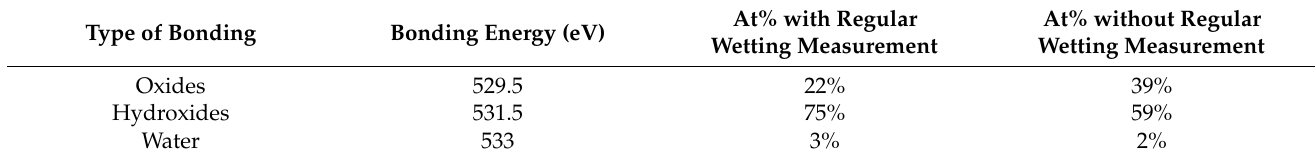
Table 3. Atomic percentages of the different oxygen bonds calculated from the O1s spectra of the samples with no square pillars’ top irradiation textured under a CO 2 flow and for which wetting evolution measurements were and were not carried out.